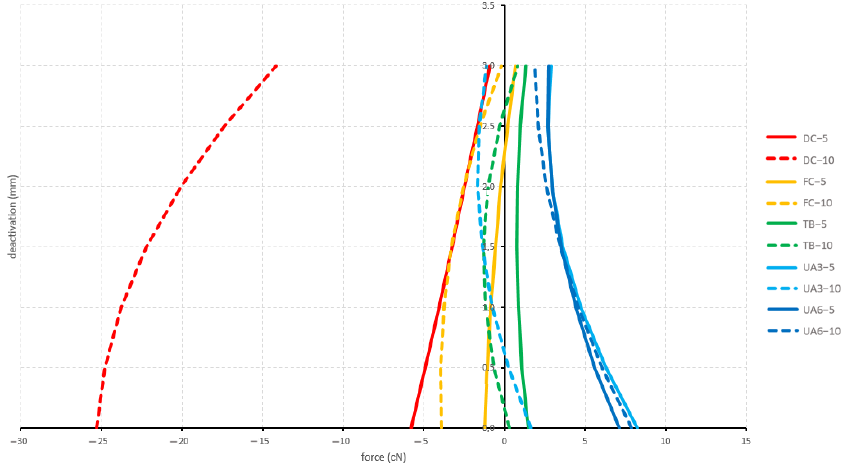
Figure 13 . Medial/lateral forces are generated by the arch-formed configurations during deactiva- tion (medial positive; lateral negative). Tested cantilever configurations origin from Figure 2.